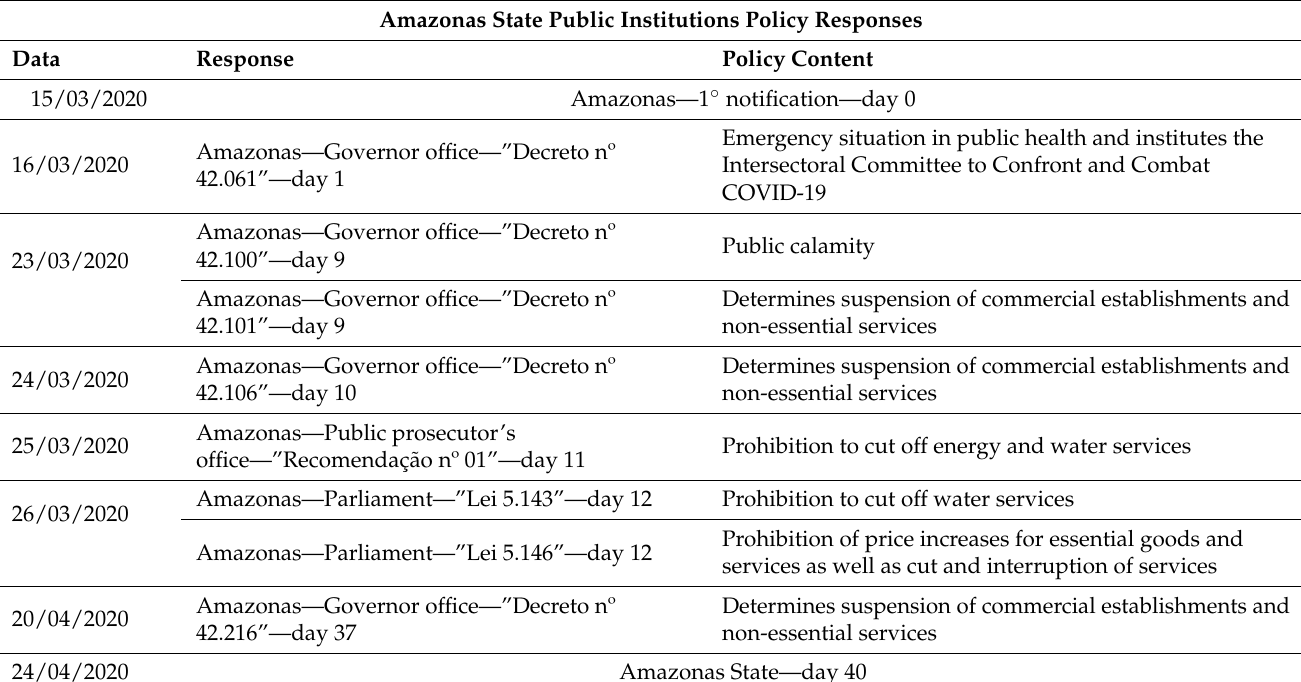
Table 3. Timeline of policy responses organized in chronological order from day 0 to day